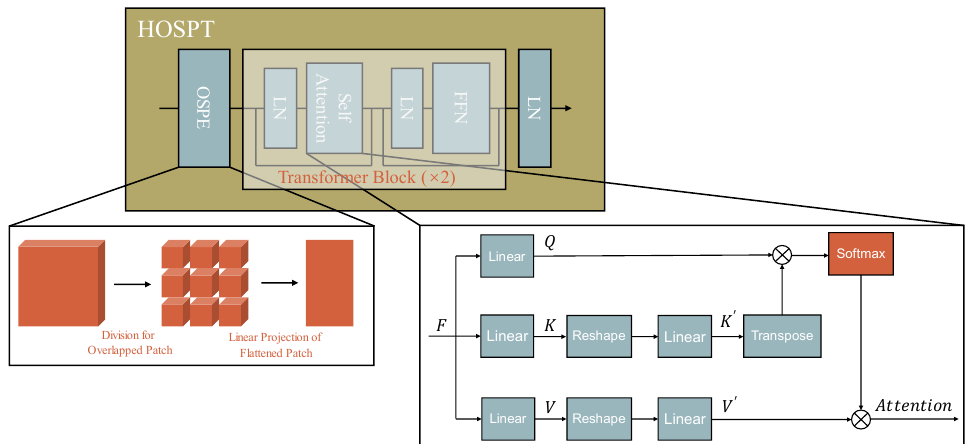
Figure 3. The architecture of each stage in the hierarchical overlapped small patch transformer (HOSPT). The overlapped small patch embedding (OSPE) divides the input feature map into different patches and conducts linear projection to obtain the two-dimension feature embedding. In the self-attention layer, attention features is calculated in form of dot-product. A 3 × 3 convolution layer is utilized in the feed-forward network (FFN). The layer normalization (LN) is utilized to normalize the